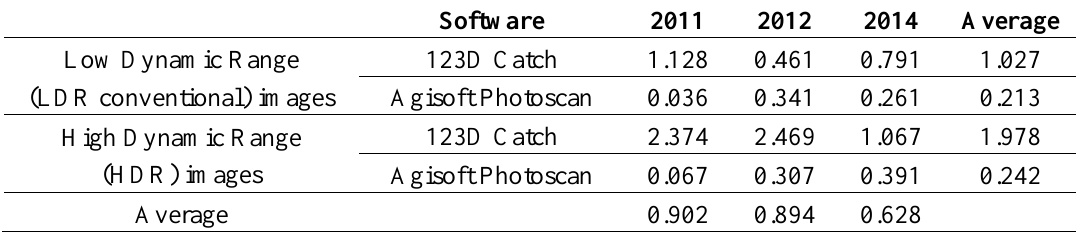
Table 2. Root Mean Square Errors (RMSEs; in meters) obtained during the scaling and referencing of each point